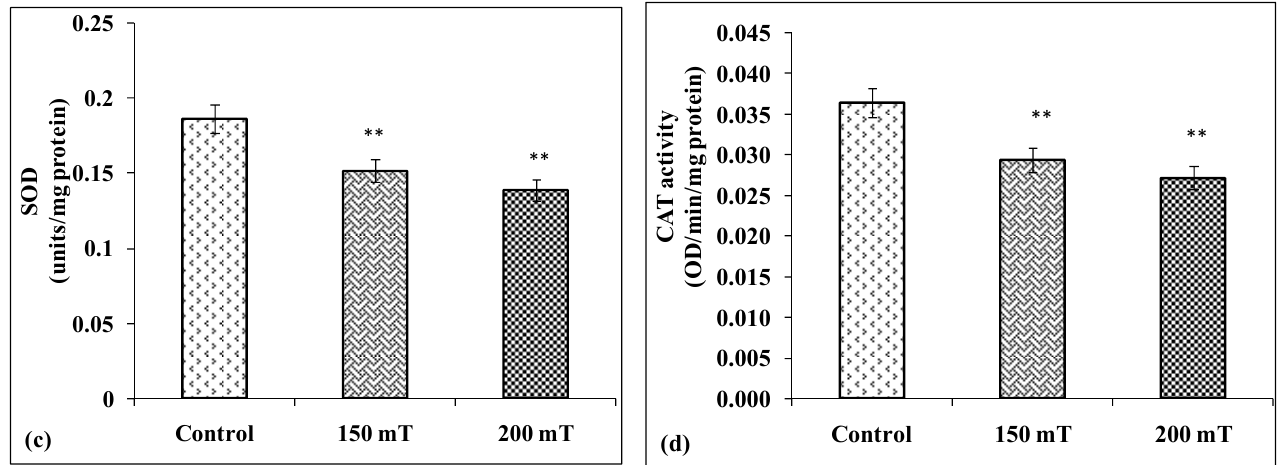
Figure 12. Effect of pre-sowing magnetic field treatment of soybean seeds on antioxidant enzymes: Ascorbate (AA) peroxidase ( a ), guaiacol peroxidase ( b ), superoxide dismutase ( c ), and catalase ( d ). *** and ** indicate significance at p < 0.001 and 0.01, respectively, compared to control.